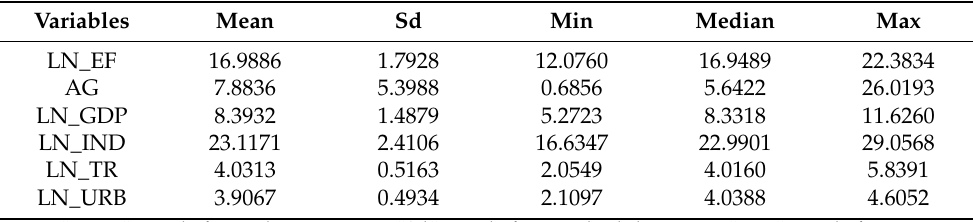
Table 2. Descriptive analysis of variables.